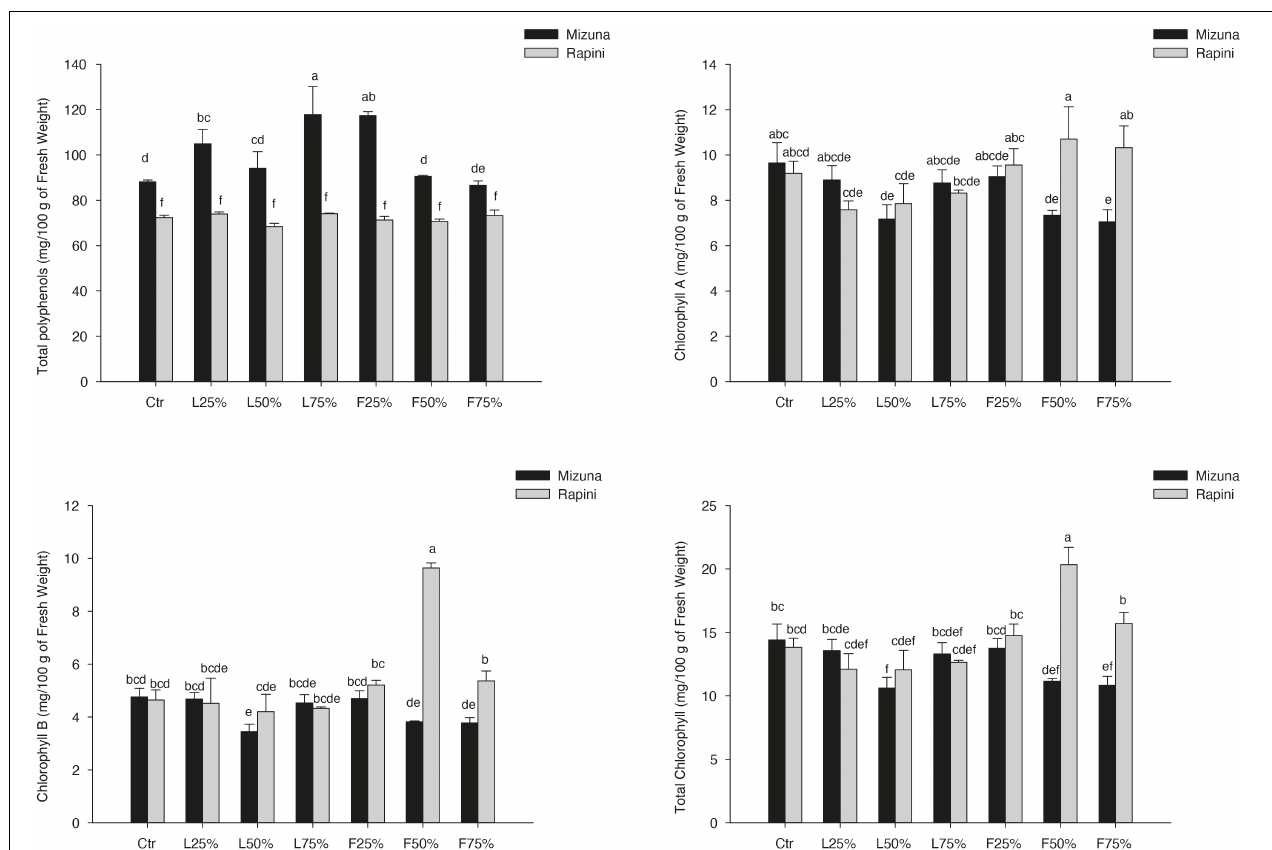
FIGURE 6 | Total polyphenols, chlorophyll A, chlorophyll B and total chlorophyll contents in Brassica rapa L. Mizuna and Rapini group microgreens, produced in greenhouse, as effected by Posidonia oceanica (L.) Delile (PO) leaves (L) and fibers (F) in the growing media. CTR (control 100% peat), L 25% (75% peat and 25% PO L), L 50% (50% peat and 50% PO L), L 75% (25% peat and 75% PO L), F 25% (75% peat and 25% PO F), F 50% (50% peat and 50% PO F) and F 75% (25% peat and 75% PO F). Significance: ** P ≤ 0.01 (Total polyphenols); * P ≤ 0.05 (Chlorophyll A); *** P ≤ 0.001 (Chlorophyll B and Total Chlorophyll). Different letters indicate that mean values are significantly different according to the LSD test ( α =